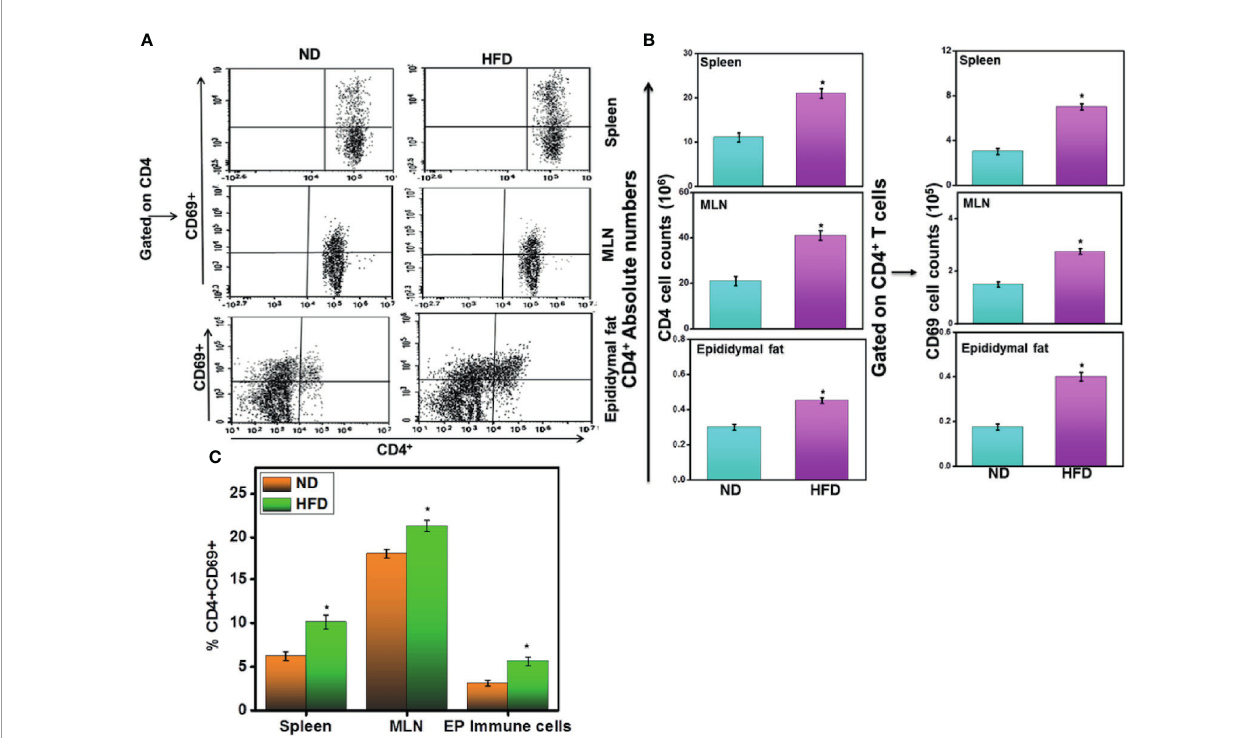
FIGURE 4 | HFD induces activated CD4 + T cells in the adipose tissue. Changes in CD4 + and CD69 + T cells in mice 16 weeks after beginning the HFD. Splenic, mesenteric lymph nodes (MLNs), and epididymal adipose cells were isolated from the two groups of mice. Changes in the numbers and percentage of CD4 + and CD69 + T cells (A, C) and CD4 + and CD69 + T cells number (B) were determined by fl ow cytometry and expressed as the mean percentage of cells/mouse ± SEM; n = 18 (six mice per group). The statistical signi fi cance between ND and HFD is assessed by Student ’ s t-test. *p < 0.05 indicate statistically signi fi cant differences in CD4 + and CD69 + T cells between ND and those fed HFD. The cumulative data shown are from a representative experiment; three independent experiments involving six mice per group yielded similar